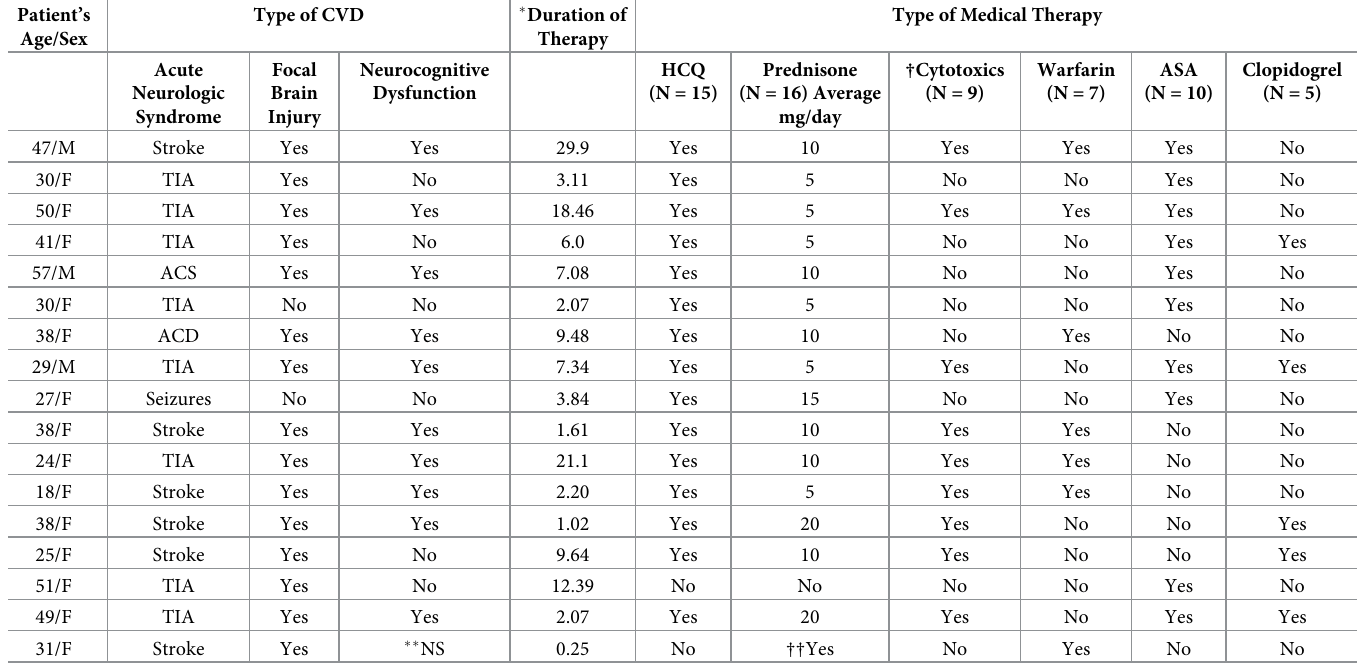
Table 1. Anti-inflammatory and Anti-thrombotic therapy in SLE patients with Libman-Sacks endocarditis and acute cerebrovascular disease.